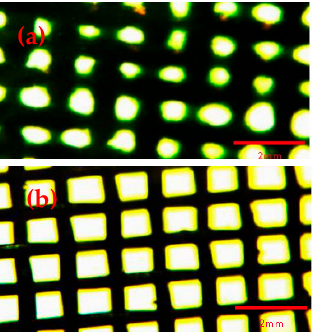
Figure 2. ( a ) Copper mesh modified by SA after etching and oxidation; ( b ) Etching of copper mesh without modification of SA after oxidation.